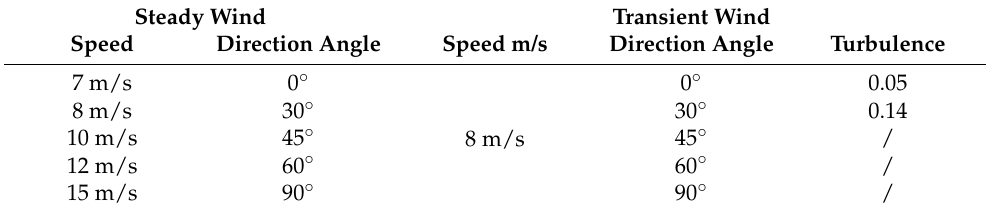
Table 3. Experimental parameters.